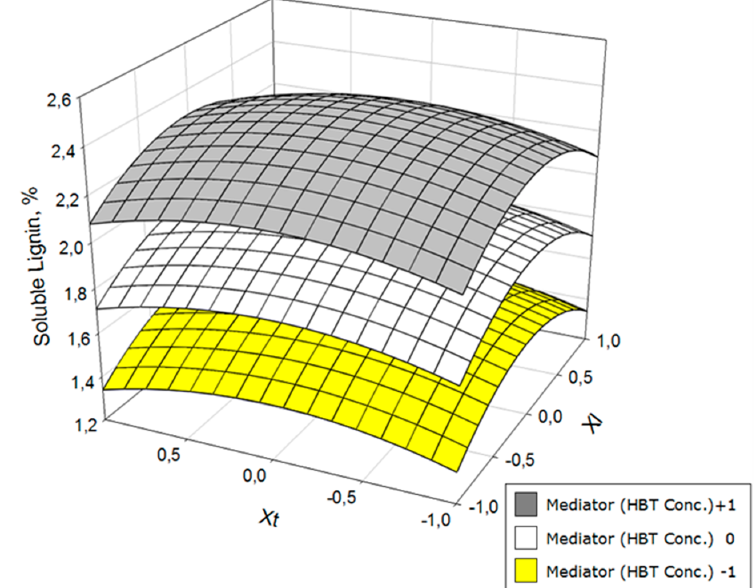
Figure 4. Variation of the acid-soluble lignin as a function of laccase concentration ( X l ) and operation time ( X t ) at three HBT concentration levels.